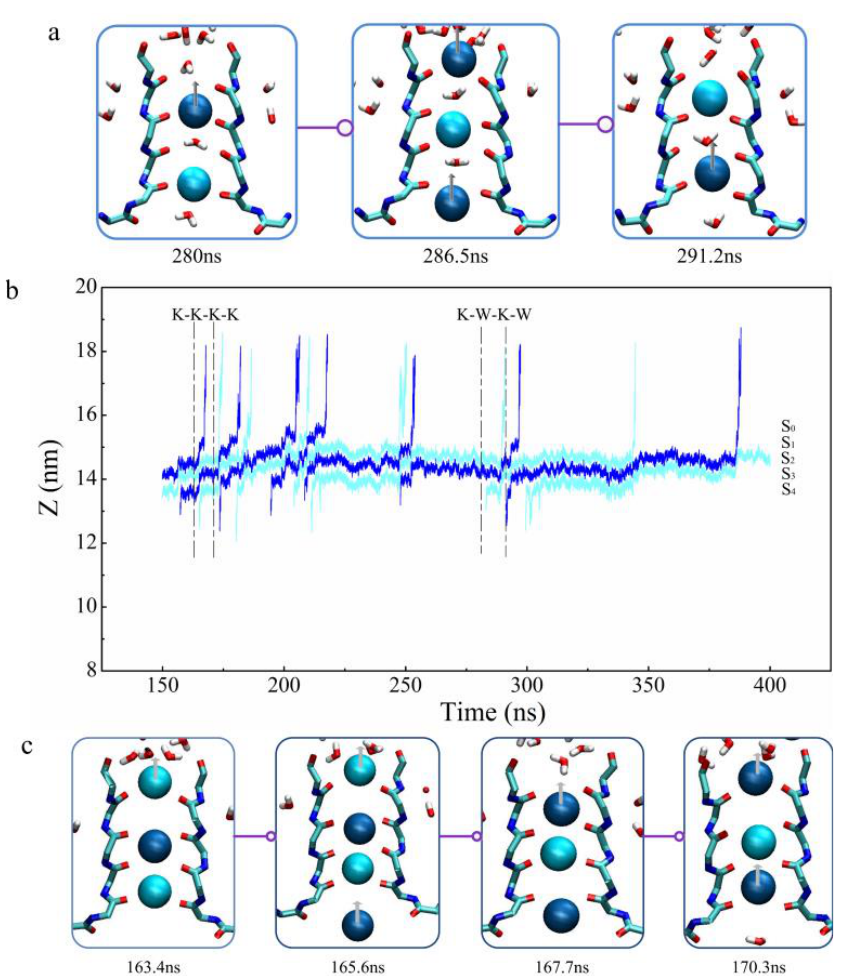
Figure 4. Ion permeation process without the external field randomly selected. ( b ) is a representative trajectory of K + passing through the SF of the KcsA channel in a period of time. ( a , c ) select the representative instantaneous screenshots of K + occupying SF sites during the permeation process (We have used spheres of different shades of blue to indicate adjacent K + .). ( a ) is a ‘K-W-K-W’ (189–194 ns) pattern and ( b ) is a ‘K-K-K-K’ (288–291 ns) pattern. Therefore, we observed and analyzed the ionic configuration states in the SF region under the applied electric field of different frequencies. All cases show that potassium ions are mainly conducted by direct Coulomb knock-on, so we obtained screenshots of six states that may occur during direct ion contacts, as shown in Figure 3a. Moreover, we counted the proportions of these six states and the states that achieved K + conduction by soft knock-on mechanism, as shown in Figure 3b. When the applied field frequency is 50 THz and 53 THz, the conduction states of soft knock-on appear the most, among which it occupies 51.47% in the case of the 53 THz field and 42.9% in the case of the 50 THz field. In the case of the most efficient permeation of 51.87 THz field, the permeation process of soft knock-on only appeared at 7.5%. In the absence of the external THz field, the ion soft knock-on conduction process in the channel accounted for 18.75%. ‘KKKW’ and ‘K0KK’ are the two most populated states, and the probability of these two states appearing with the applied field at 50 THz and 53 THz is significantly less than that with the applied field at 51.87 THz and without the applied electric